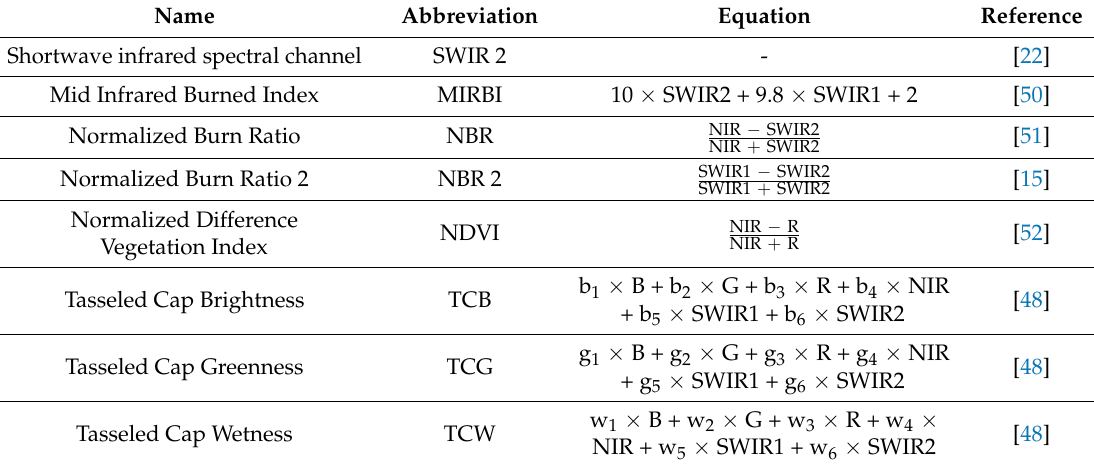
Table 1. Set of spectral variables evaluated for change